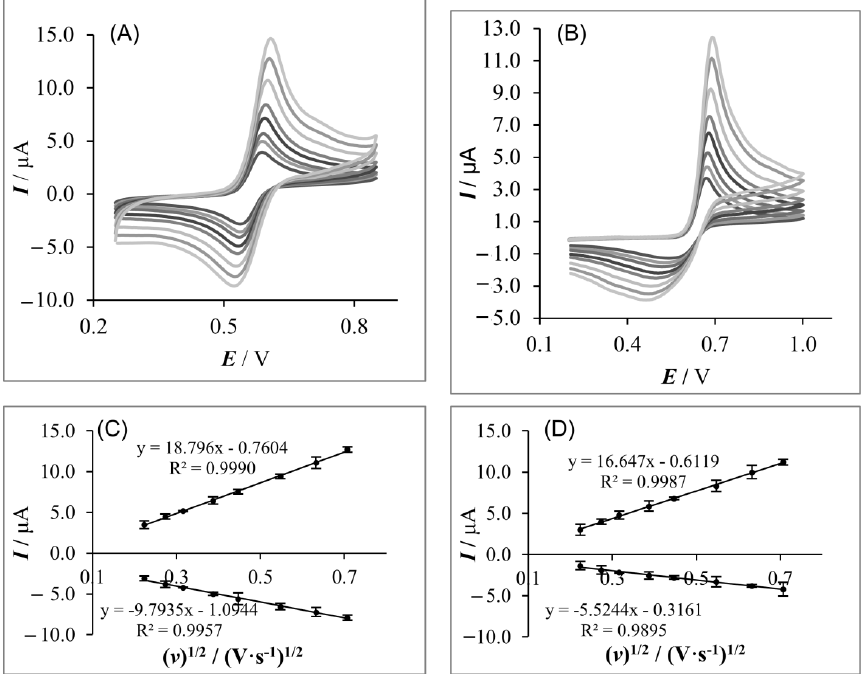
Figure 4. Cyclic voltammograms of 0.1 mmol L −1 AC on GFPE ( A ) and MLGPE ( B ) at different scan rates of 50, 75, 100, 150, 200, and 300 mV · s −1 in Britton–Robinson buffer at pH 5.0. ( C ) The dependence of AC peak current on square root of scan rate for GFPE (n = 3) and ( D ) The dependence of AC peak current on square root of scan rate for MLGPE (n = 3).